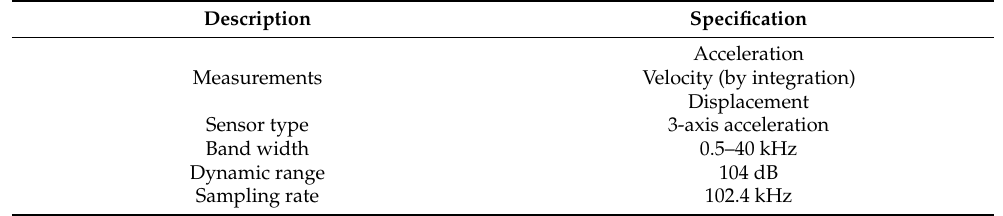
Table 4. Specifications of the vibration data collector used for the